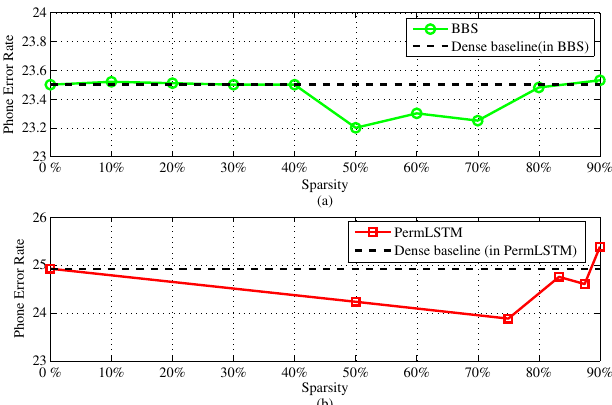
Figure 6. Phone error rate vs. sparsity on the TIMIT dataset. ( a ) Evaluted on Bank-Blanced Sparsity (BBS). ( b ) Evaluted on PermLSTM